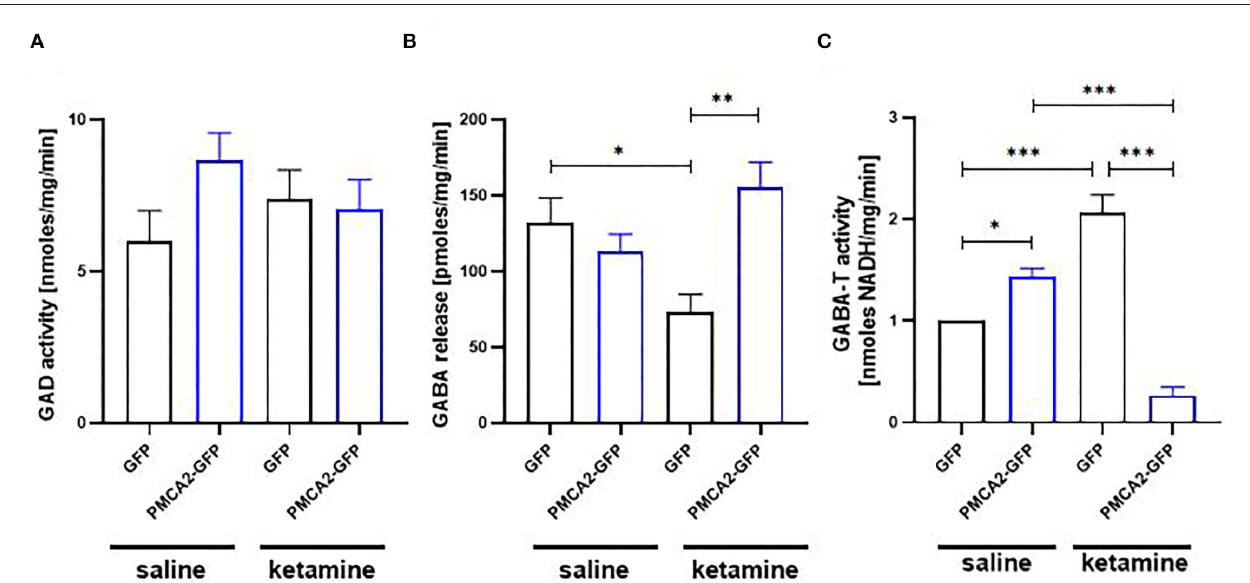
FIGURE 6 | The effect of ketamine on GABA metabolism in the presence or absence of PMCA2b. (A) The activity of GAD assayed based on the fluorometric measurement of GABA and ninhydrin condensation product. n = 4. (B) Quantification of Ca 2 + -dependent GABA release over 5min stimulation with 30mM KCl done with GABA Elisa kit. n = 3. (C) The activity of GABA transaminase (GABA-T) expressed as NADH formation measured at 340nm. n = 4. * P < 0.05, ** P < 0.01, *** P <